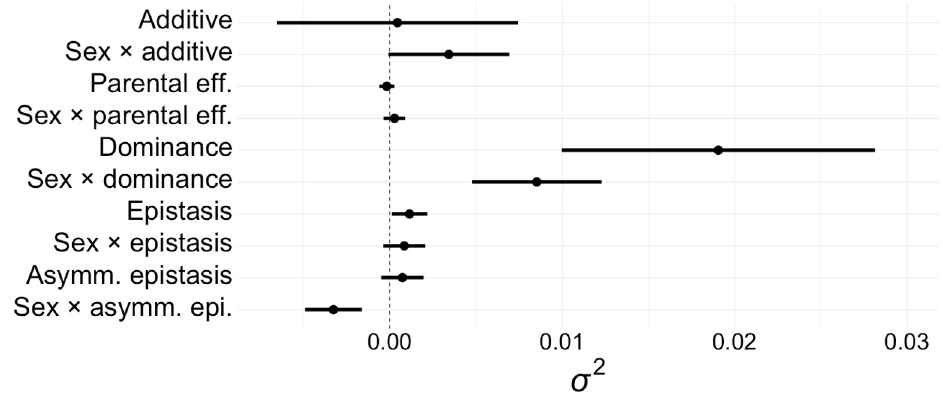
Fig 2. Graphical representation of variance partitioning. Variance components ( σ 2 , ± 1 s.e.) for fitness estimated by REML. The data underlying all figures and tables can be found in S1 Data. asymm., asymmetric; eff., effects; epi., epistasis; REML, restricted maximum likelihood; s.e., standard error.